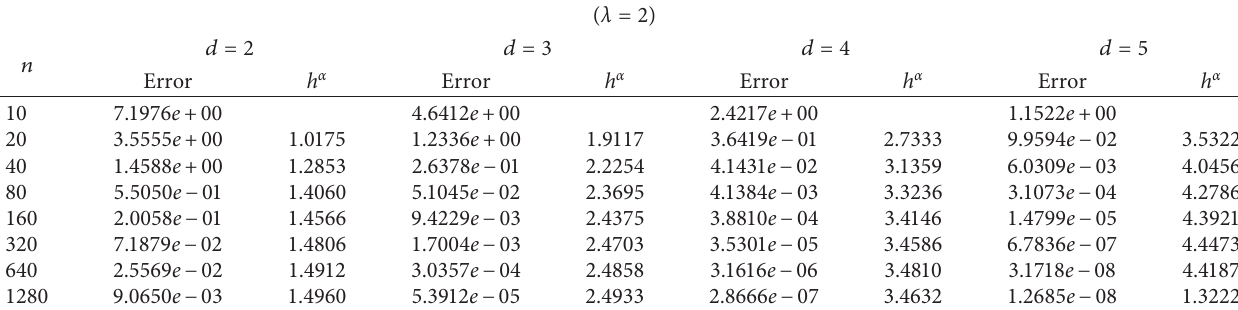
Table 2: Errors and convergence rate of the Chebyshev point with different d .